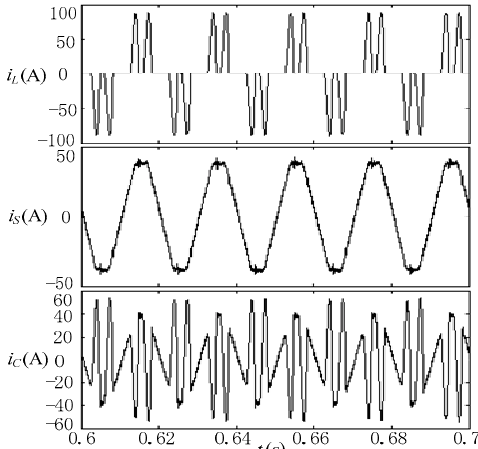
Figure 12. Steady-state waveform of the 100 μ H inductor.